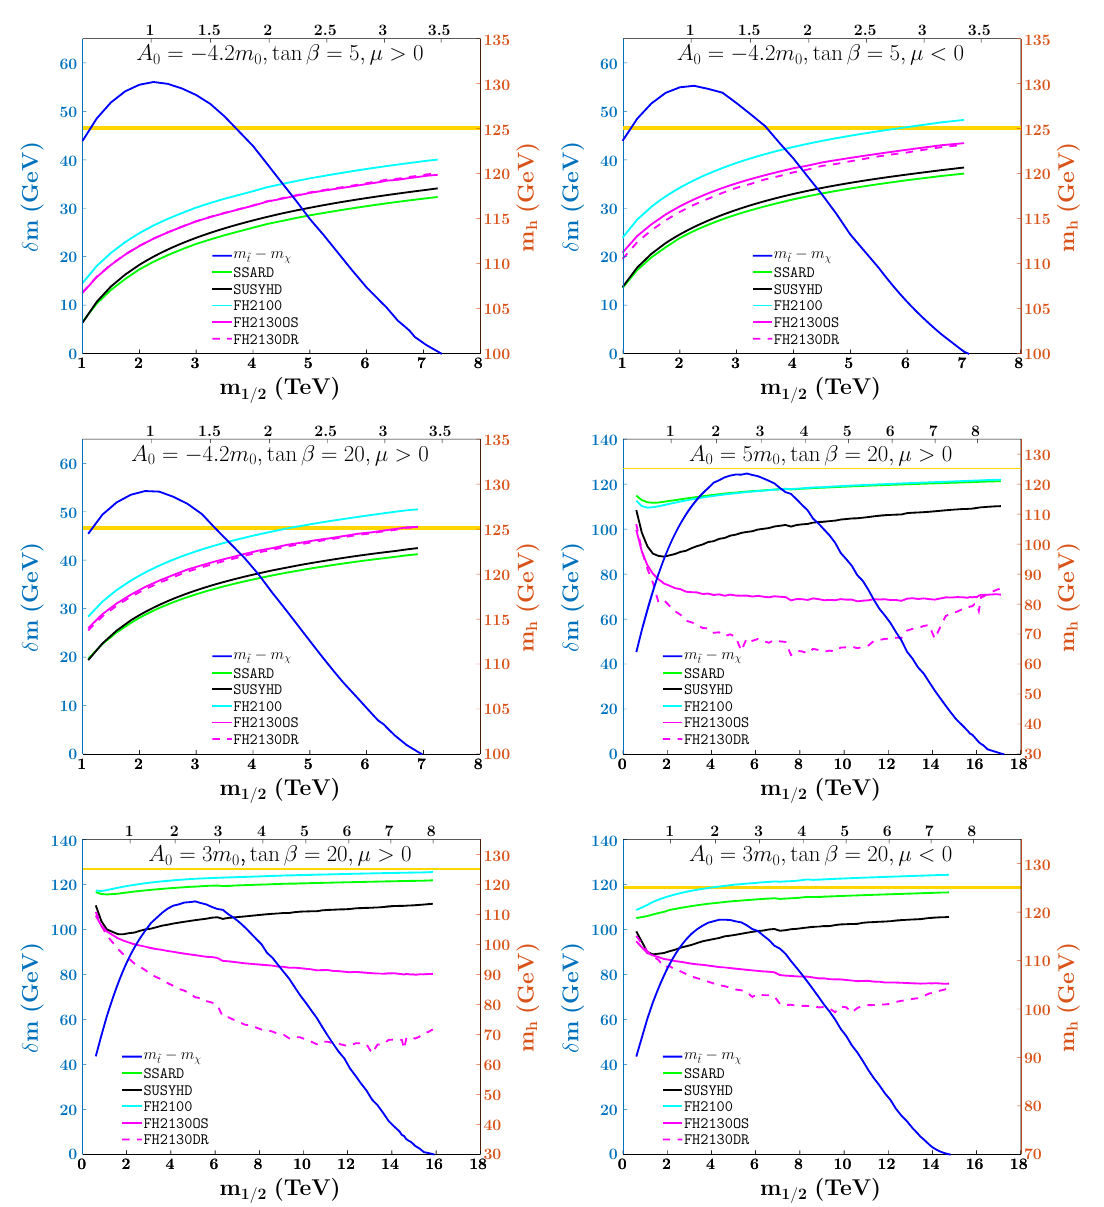
ferent codes: FeynHiggs 2.10.0 (cyan lines) and 2.13.0 (purple Fig. 3 The stop coannihilation strips for A 0 = − 4 . 2 m 0 , tan β = 5 lines), SSARD (green lines) and SUSYHD (black lines). The horizon- and both positive or negative μ (upper panels), for A 0 = − 4 . 2 m 0 , tal yellow strip corresponds to the 1 σ band for the Higgs boson mass, tan β = 20 and μ > 0 (middle left panel), A 0 = 5 m 0 , tan β = 20 and μ > 0(middlerightpanel)and A = 3 m β = 20andbothpositive M h = 125 . 09 ± 0 . 24 GeV 0 0 ,tan or negative μ (lower panels) with the Higgs mass calculated using dif-